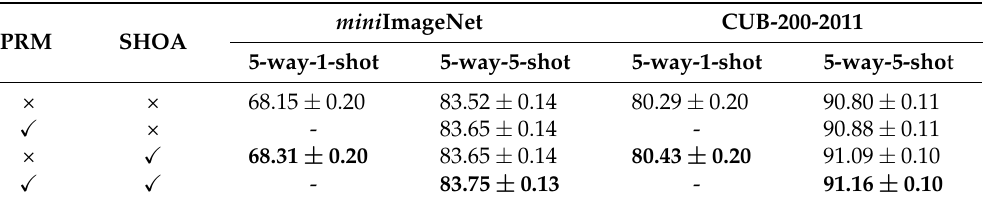
Table 4. Ablation study on mini ImageNet and CUB-200-2011 for 5-way-1-shot and 5-way-5-shot settings, the